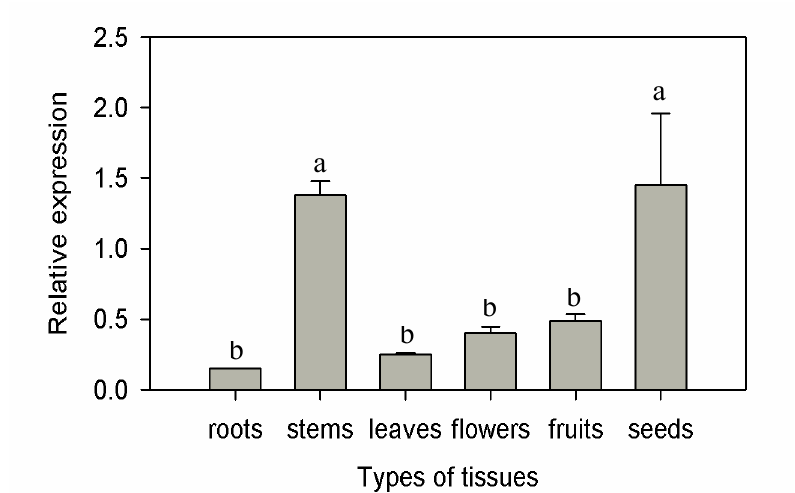
Figure 3. Tissue-specific expression of CaF-box in different tissues of pepper plants. Error bars represent the mean ± SD of three independent biological replicates. Different letters indicate significant differences ( p <